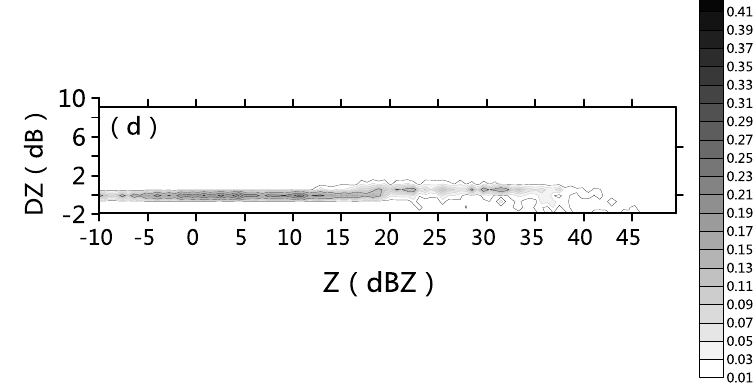
Figure 21. Two-dimensional occurrences of reflectivity differences by C and Ka band radars from DSD data by the disdrometer.